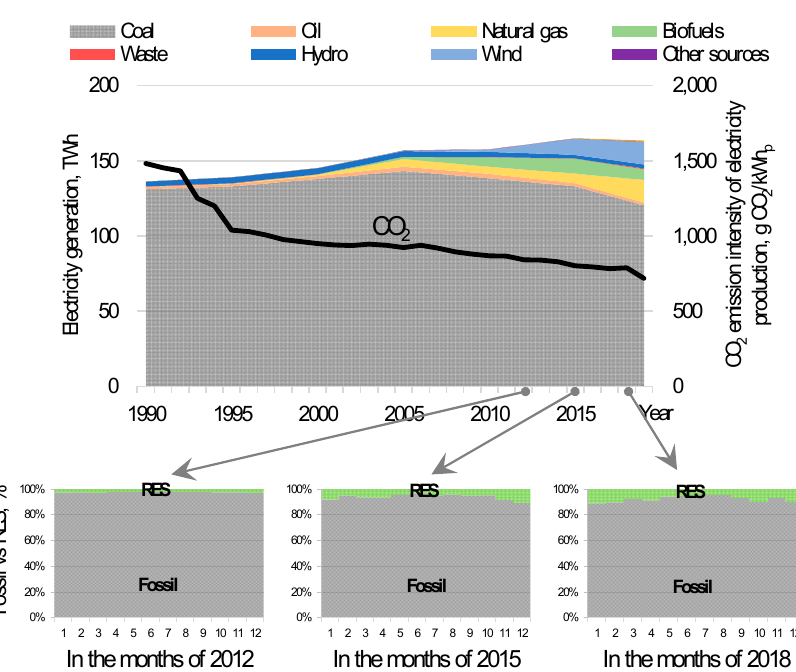
Figure 2. Fuel mix and CO ₂ emission intensity of the Polish power system (data sources [9–13]).